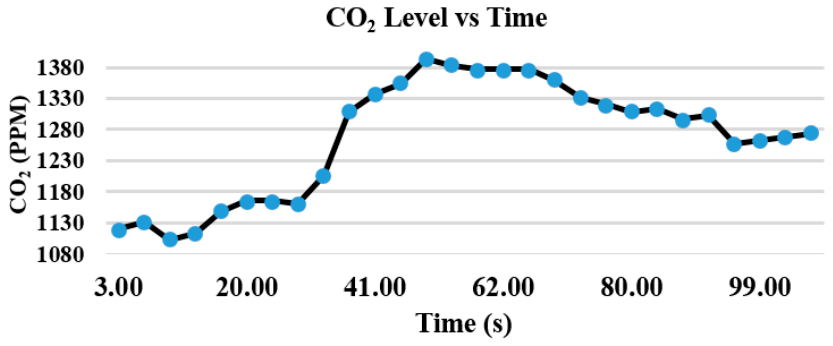
Figure 5. The recorded CO 2 level resultant from this fire hazard event.